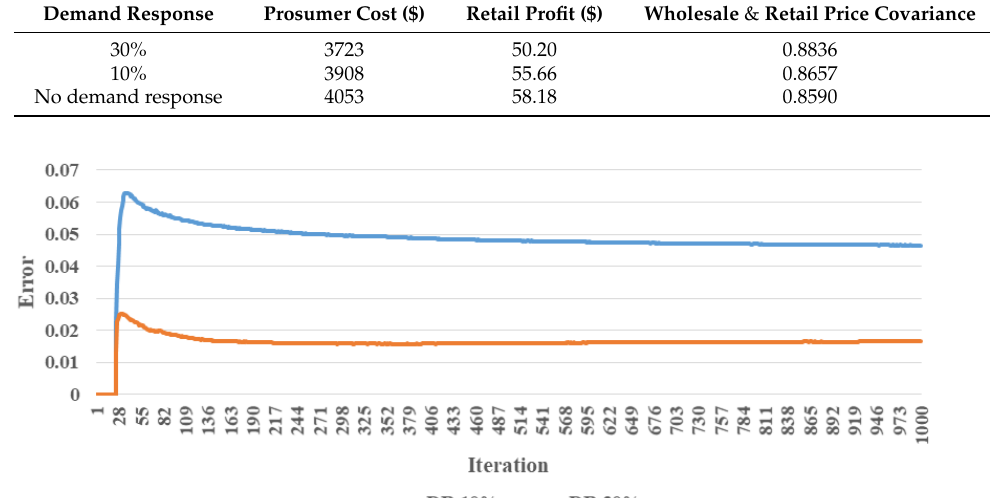
Table 6. Comparison of demand response with prosumer cost, retailer profit, and correlation coefficient.